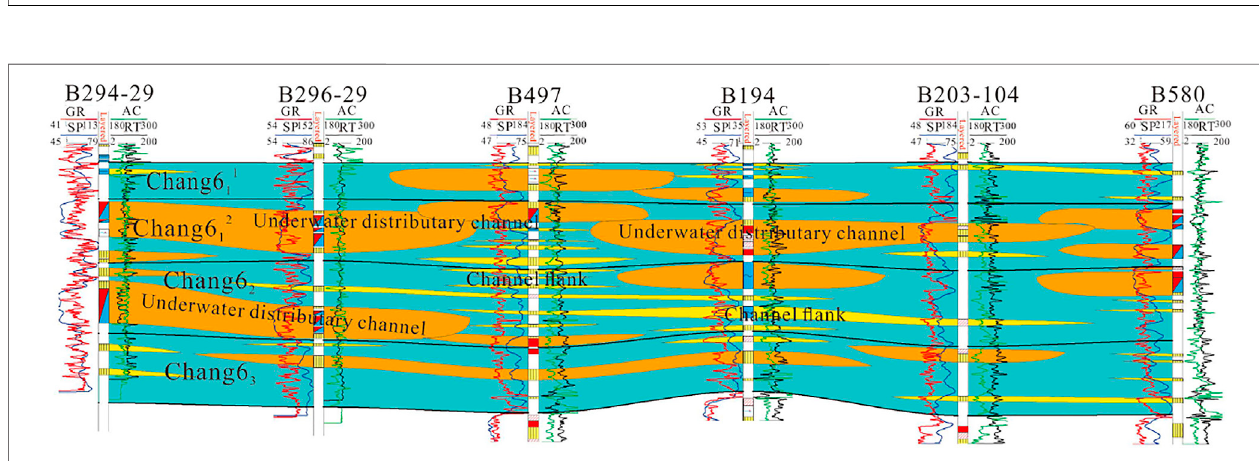
Frontiers in Earth Science |